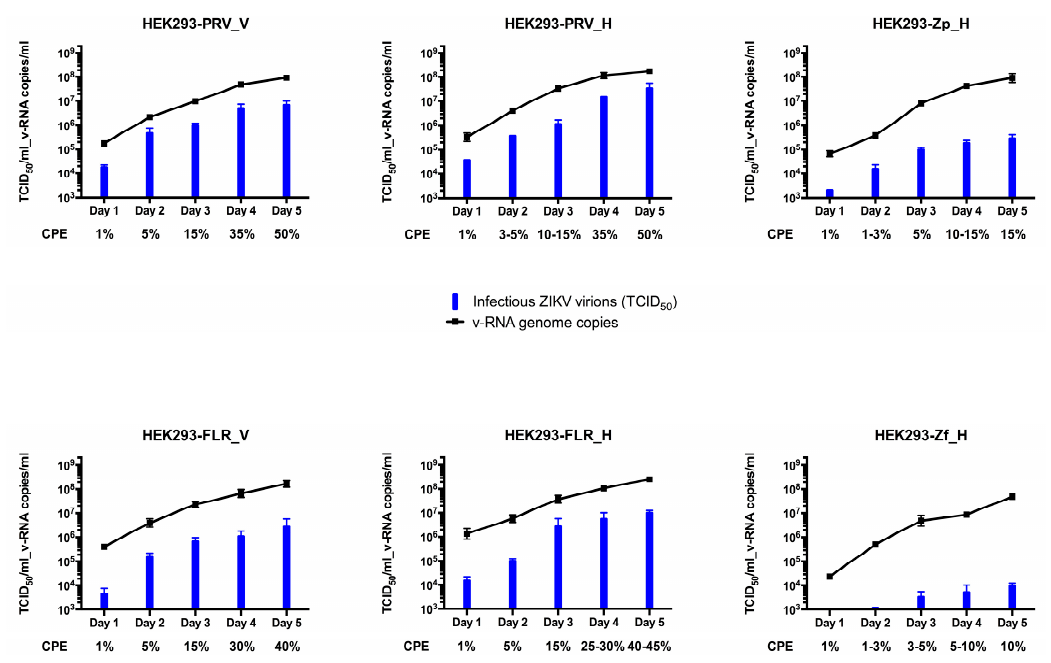
Figure A1. Production of ZIKV RNA genomes and infectious virions in naïve HEK293 cells infected with ZIKVs present in the supernatants of acutely and persistently PRV and FLR strains of ZIKV-infected cultures. HEK293 cells were infected by ZIKVs (PRV_V, PRV_H, Zp_H, FLR_V, FLR_H, Zf_H) using supernatant aliquots with the same genomic copy number from 6 cell cultures (Vero / PRV, HEK293 / PRV, HEK293_Zp, Vero / FLR, HEK293 / FLR, HEK293_Zf). Quantitation of v-RNA ZIKV genomes by RT-PCR and titration of infectious ZIKV virions by the TCID50 assay were examined using supernatants of cell culture aliquots collected daily. The error bars represent the triplicate for each measurement conducted at each time point of the study.